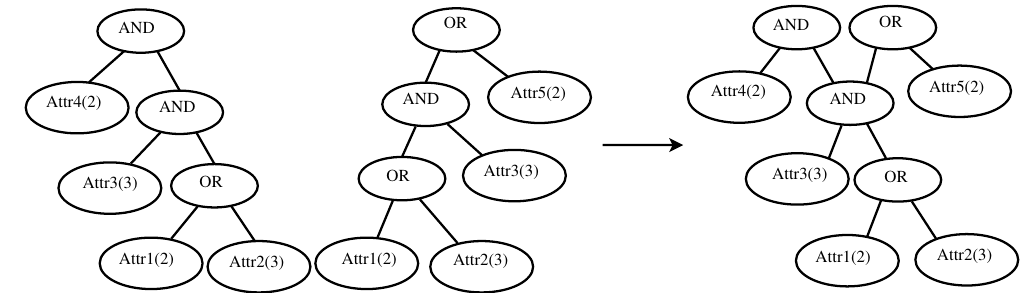
Figure 3. The merging process of two weighted access